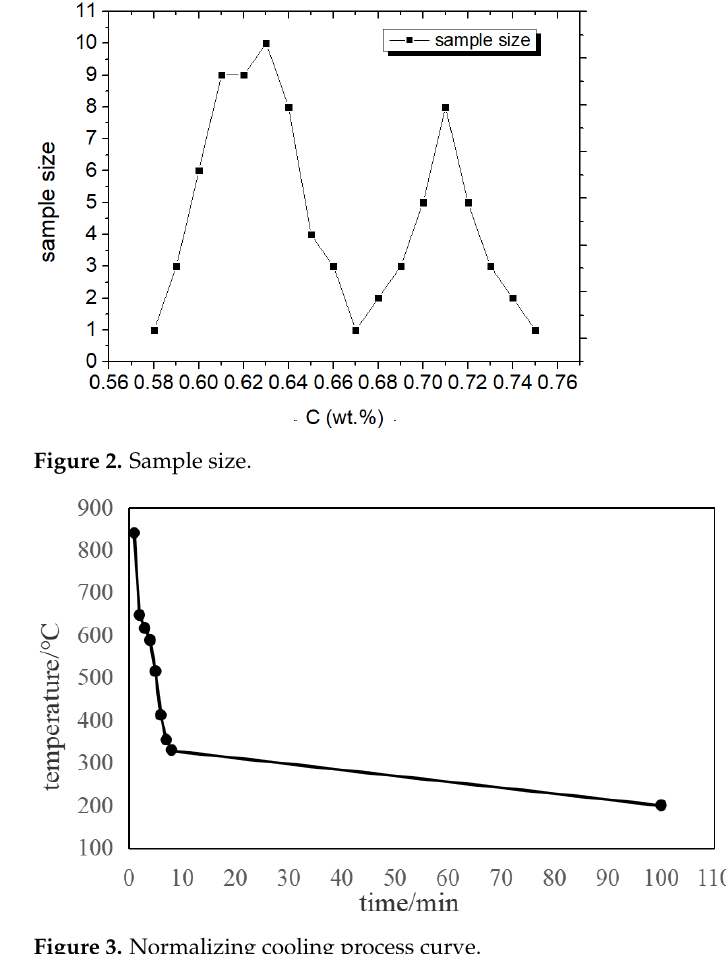
Figure 3. Normalizing cooling process curve.